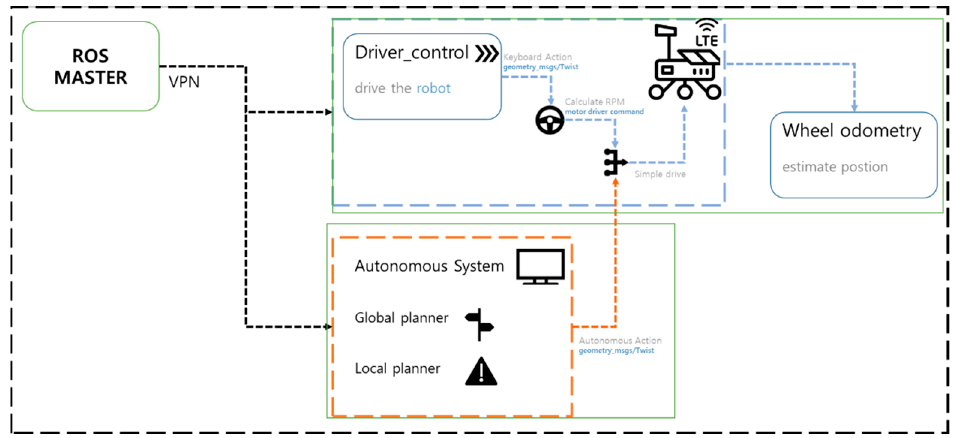
Figure 6. Proposed mobile robot system.